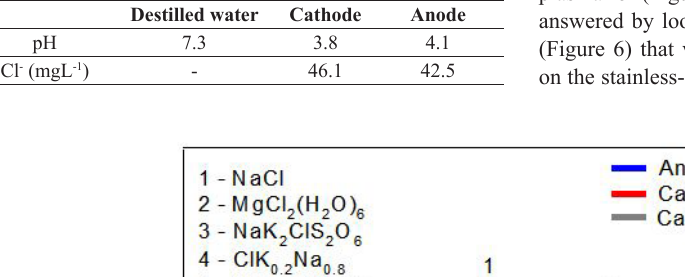
Table 2. Mass concentration and pH of the bubbler water before and after plasma treatment. Destilled water